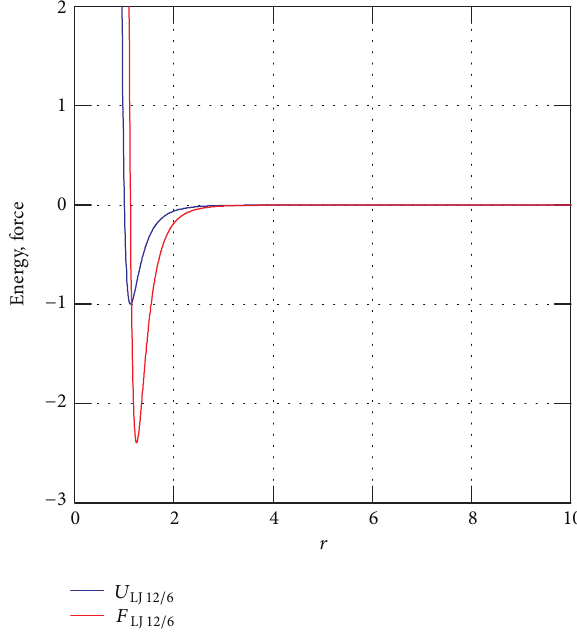
Figure 4: Energy, force relationship of functional bead to functional bead and functional bead to DLC C atoms as a function of 𝑟